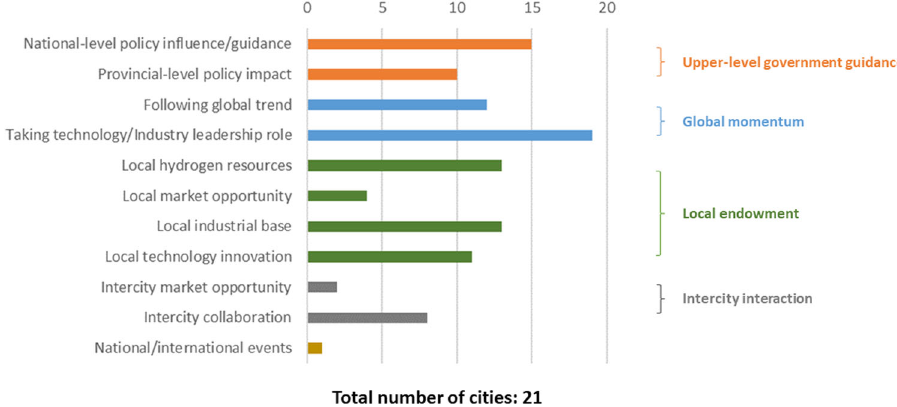
Fig. 6 Motivations of frontrunner cities to develop the hydrogen economy. Bar length represents the number of